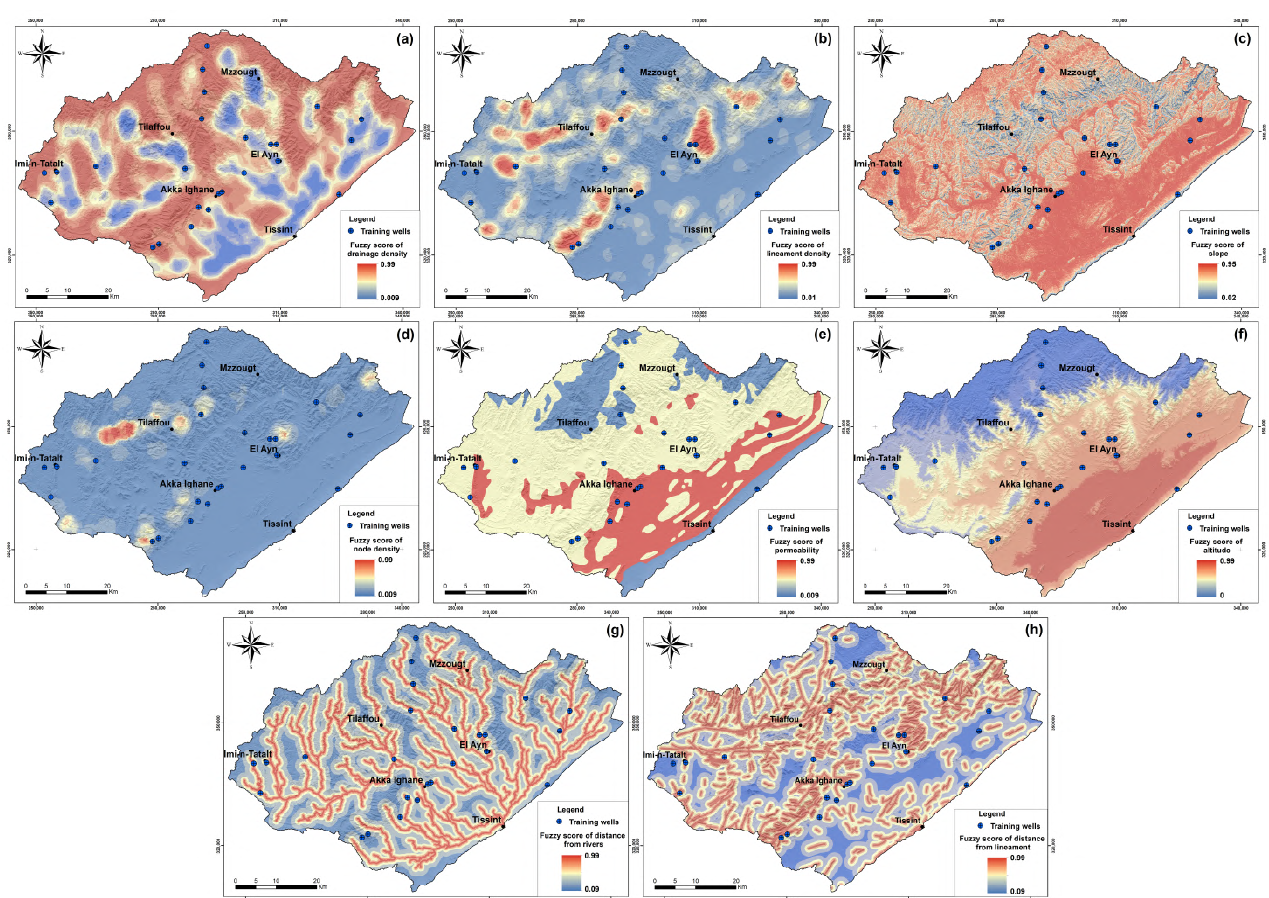
Figure 4. Maps of transformed values: ( a ) drainage density map; ( b ) lineament density map; ( c ) slope map; ( d ) node density map; ( e ) permeability map; ( f ) altitude map; ( g ) distance from rivers map; ( h ) distance from lineament map.